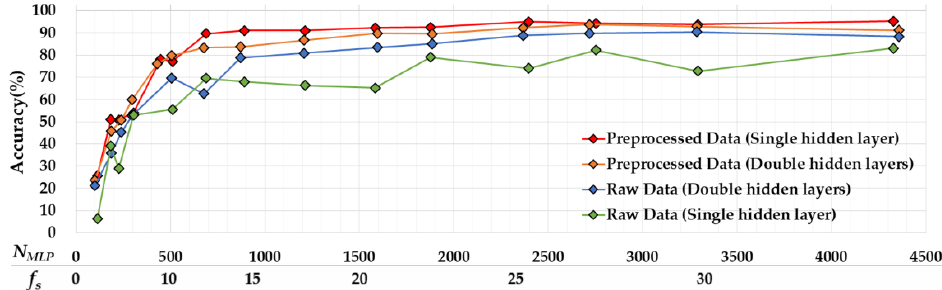
Figure 10. Recognition accuracy comparisons by increasing 𝑁 𝑀𝐿𝑃 .